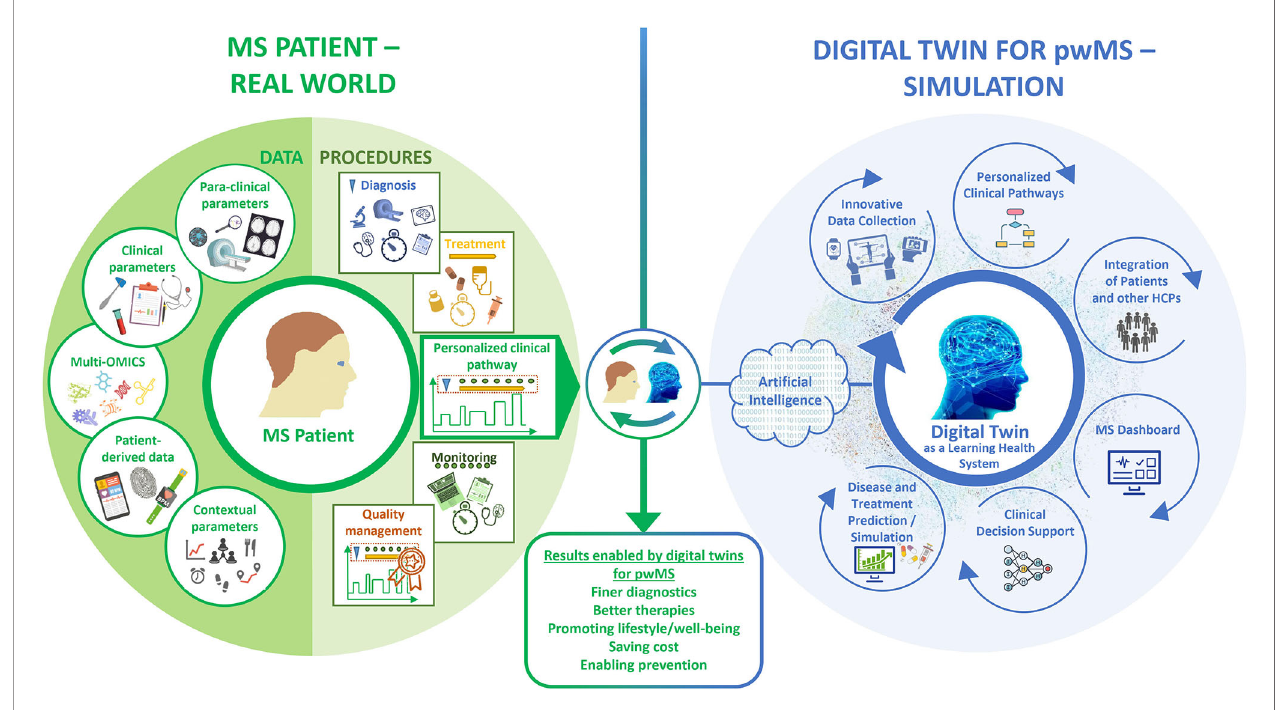
FIGURE 1 | Concept of a digital twin for